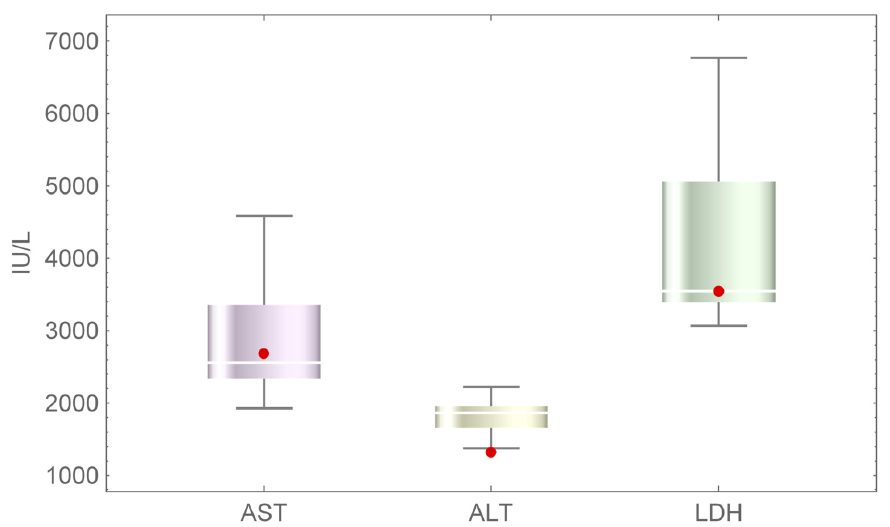
Fig 1. Bio-marker data collected from literature to include cases of ischaemic hepatitis due to low O 2 availability, low O 2 delivery. The (mean, standard deviation) IU/L of AST, ALT, LDH are (2877.0, ffiffiffiffiffiffiffiffiffiffiffiffiffiffi p (4273.8, 1486 : 9 )